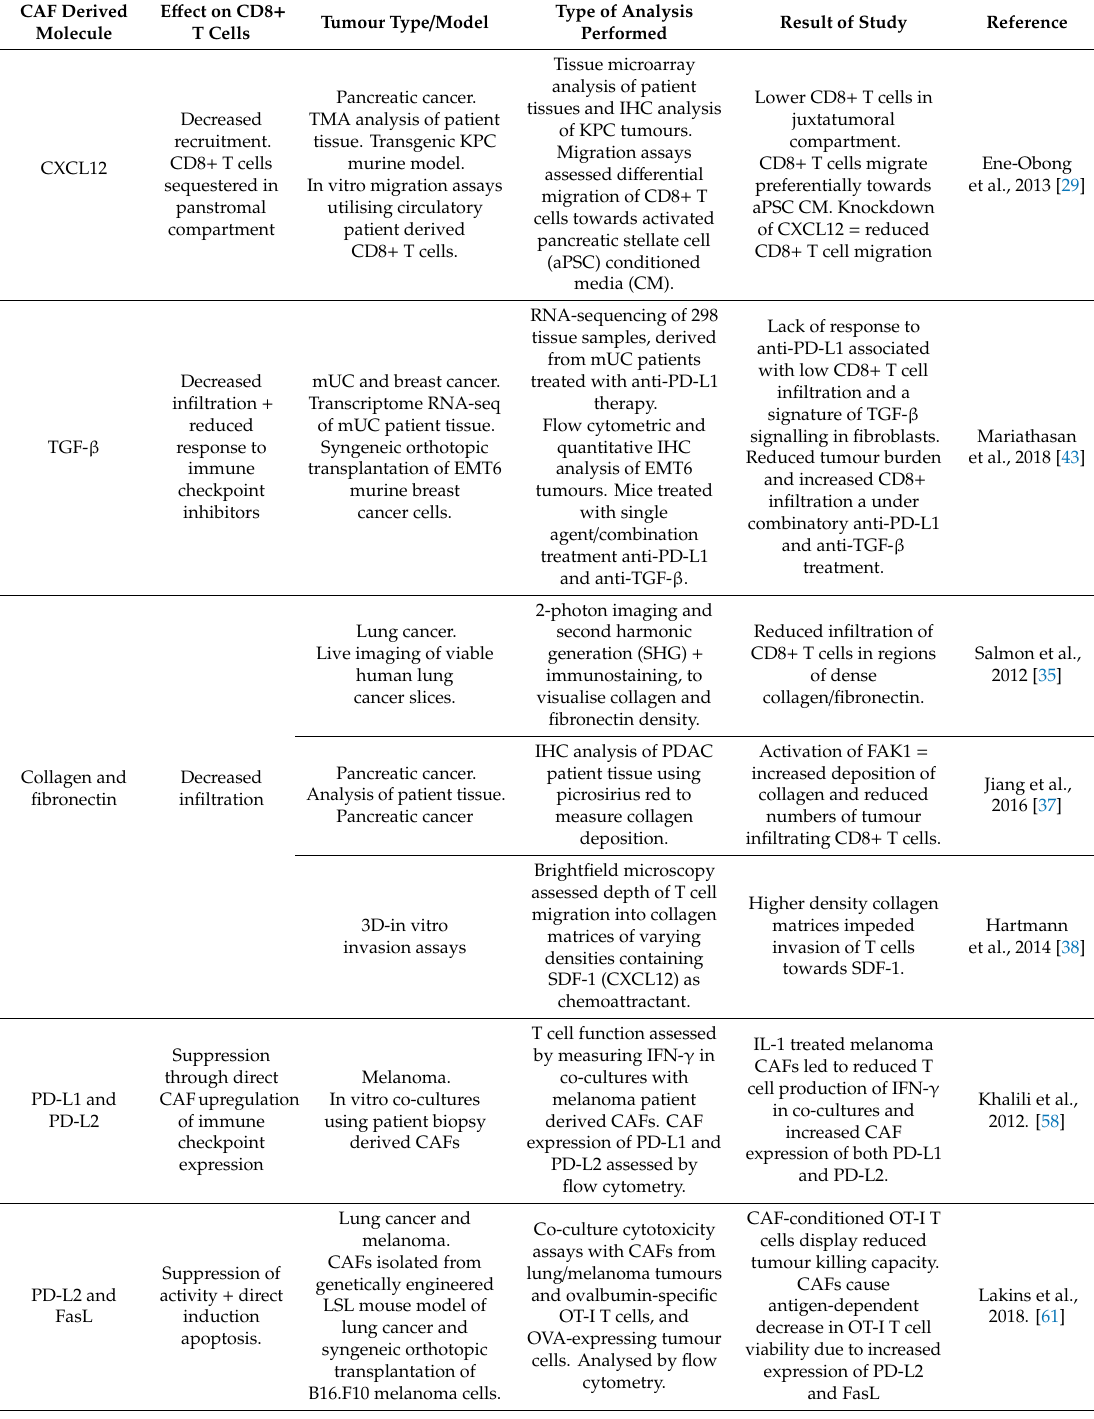
Table 1. Summary of CAF-derived molecules / factors responsible for the inhibition of CD8 + T cells through interference with T cell-tra ffi cking / recruitment, infiltration and cytotoxic function. CAF Derived E ff ect on CD8 + Molecule T